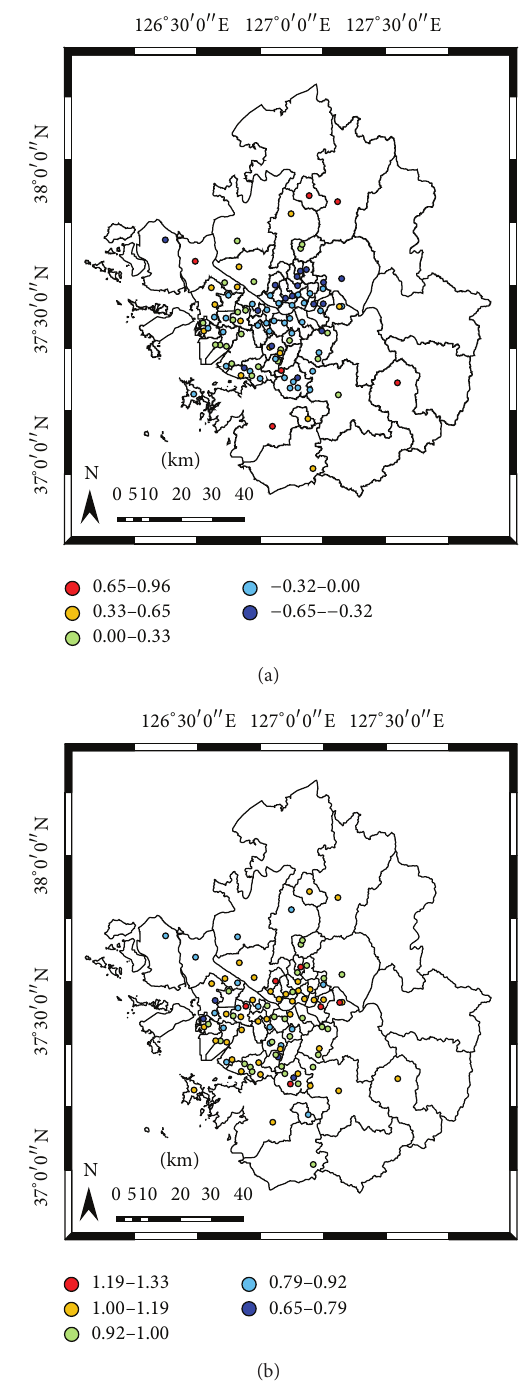
Figure 4: Two coefficients of local temporal trend components at monitoring stations: (a) intercept and (b)